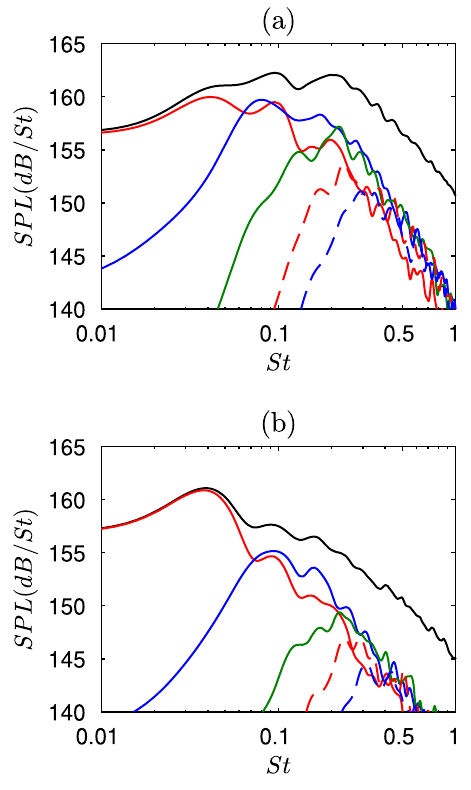
Figure 8. Sound pressure spectra at z = 0 and r = 2 r 0 for (a) L = 15 r 0 and (b) L = 25 r 0 : full spectra and modes n h =